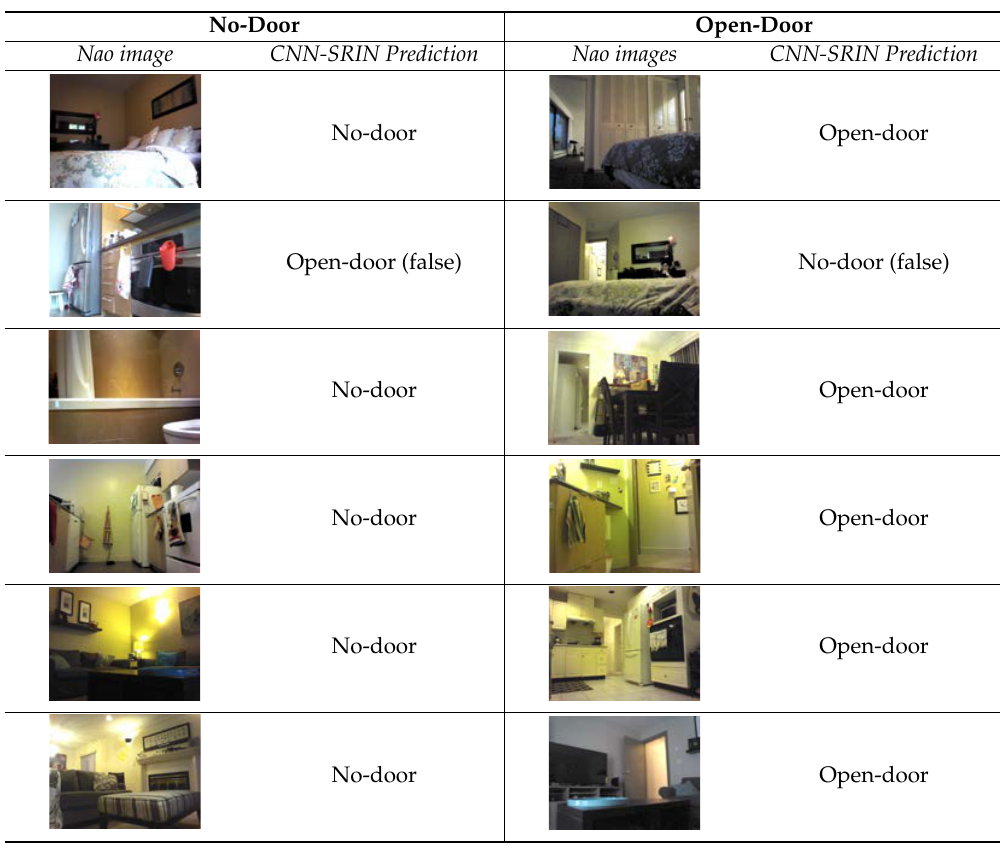
Table 1. CNN-Social Robot Indoor Navigation (SRIN) doorway prediction results on Nao.